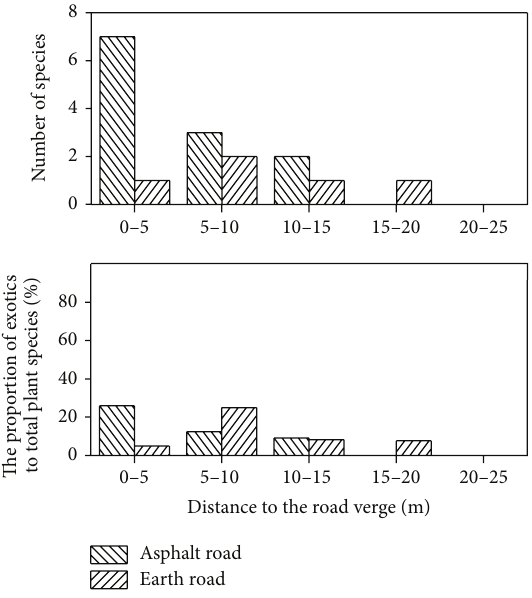
Figure 3: Number and proportion of alien plant species in plots of asphalt roadsides and earth roadsides.